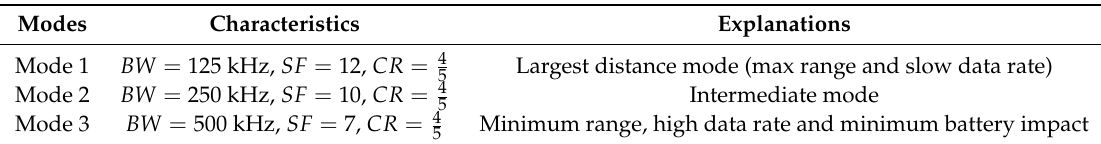
Table 5. Different LoRaWAN modes